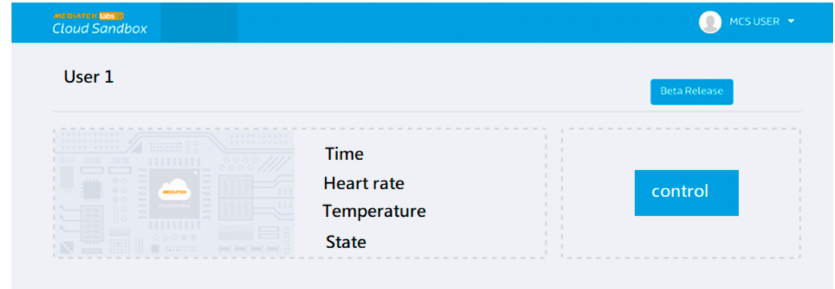
Figure 7. MCS multiplayer management